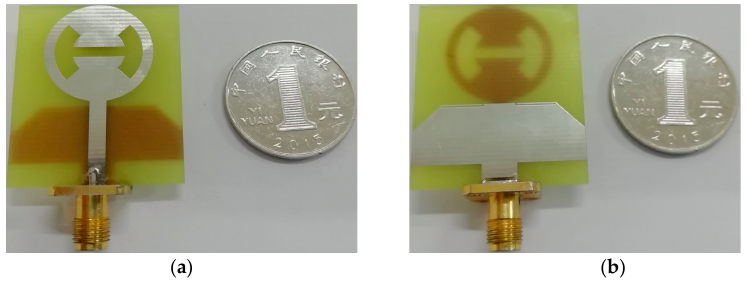
Figure 8. Photo of the fabricated antenna: ( a ) front view; ( b ) back view.